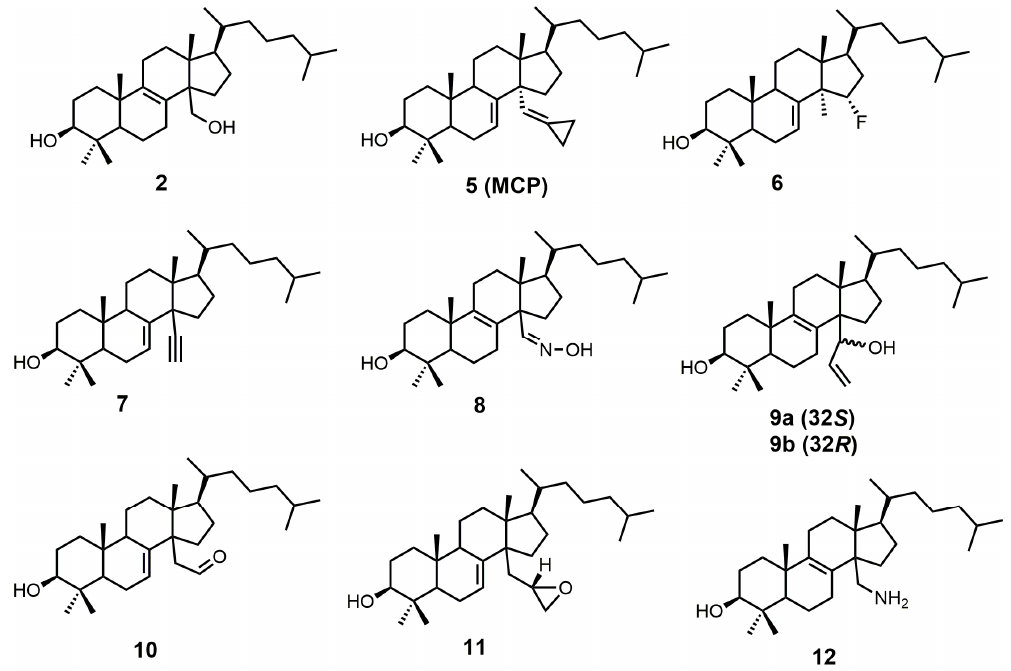
Figure 3. Sterol-based inhibitors of sterol 14 α -demethylase (SDM).